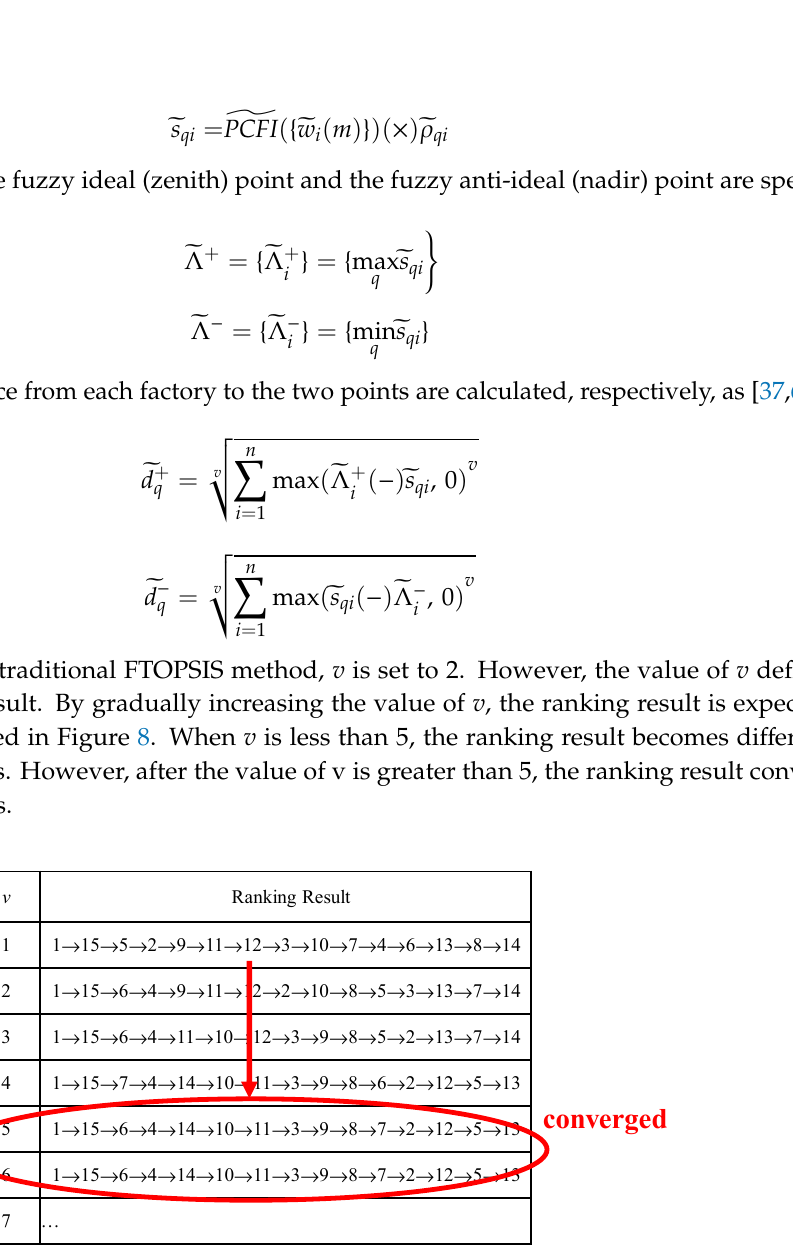
Figure 8. The convergence process of the ranking result.